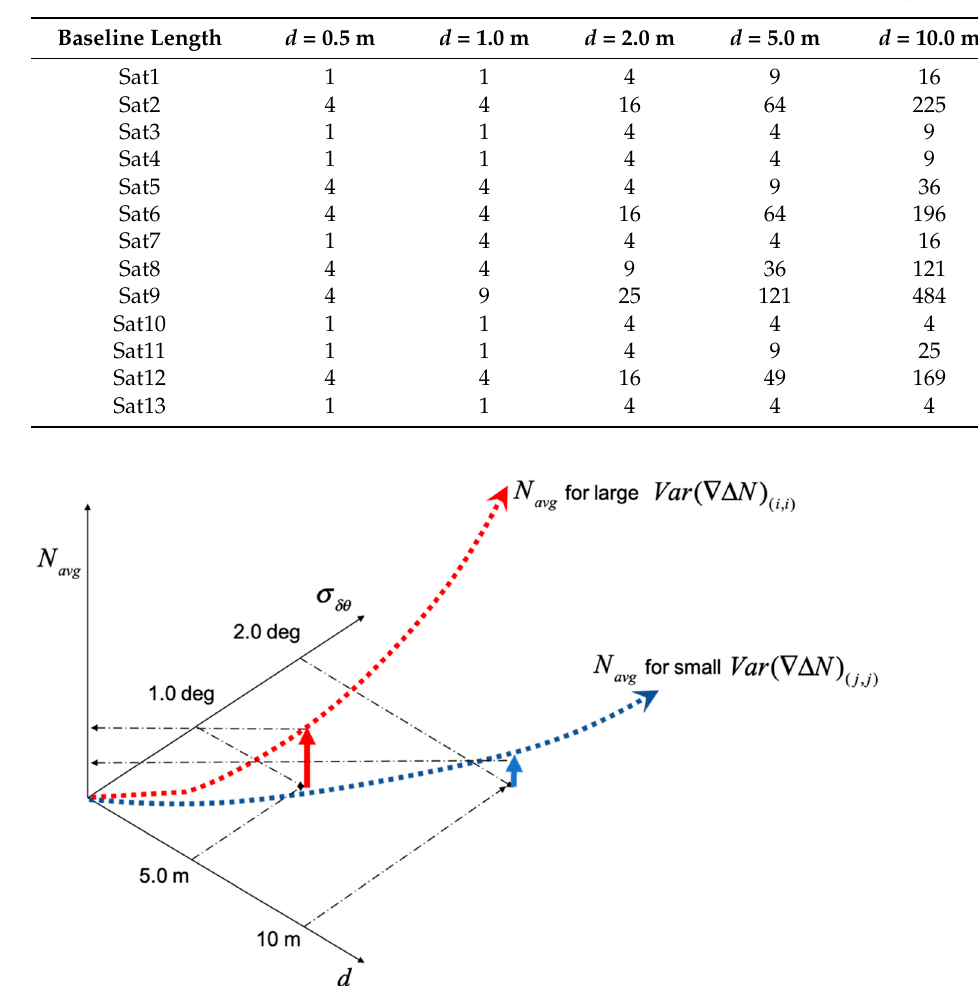
Table 2. The number of required averaging epochs to achieve σ ∇ ∆ ˆ baseline lengths. The simulation set up is identical to the one used in Table 1 except for σ